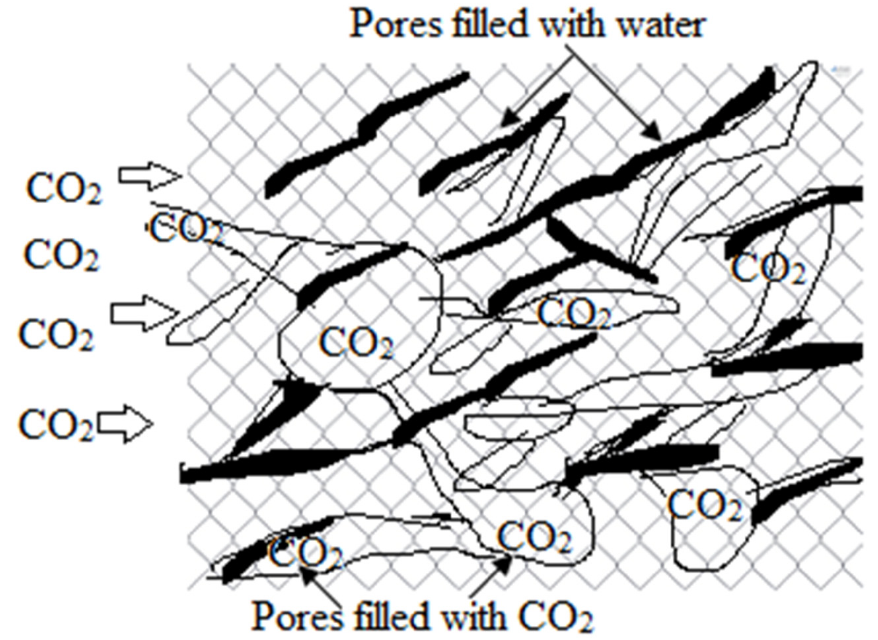
Figure 1. Carbonation assisted by water and CO 2 adsorption